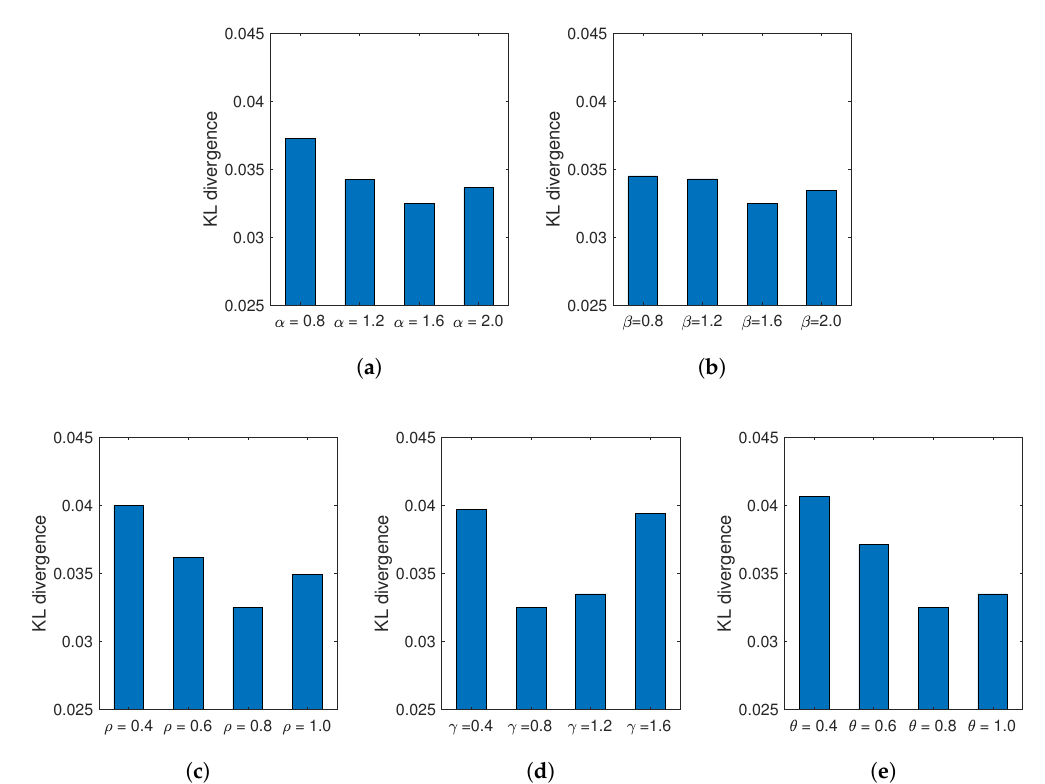
Figure 5. KL divergence between the real trace flight distribution and the synthetic ones generated by SRMM using various values for the parameters. ( a ) Various α values ( β = 1.6, ρ = 0.8, γ = 0.8, θ = 0.8). ( b ) Various β values ( α = 1.6, ρ = 0.8, γ = 0.8, θ = 0.8). ( c ) Various ρ values ( α = 1.6, β = 1.6, γ = 0.8, θ = 0.8). ( d ) Various γ values ( α = 1.6, β = 1.6, ρ = 0.8, γ = 0.8, θ = 0.8 ) . ( e ) Various θ values ( α = 1.6, β = 1.6, ρ = 0.8, γ = 0.8 )